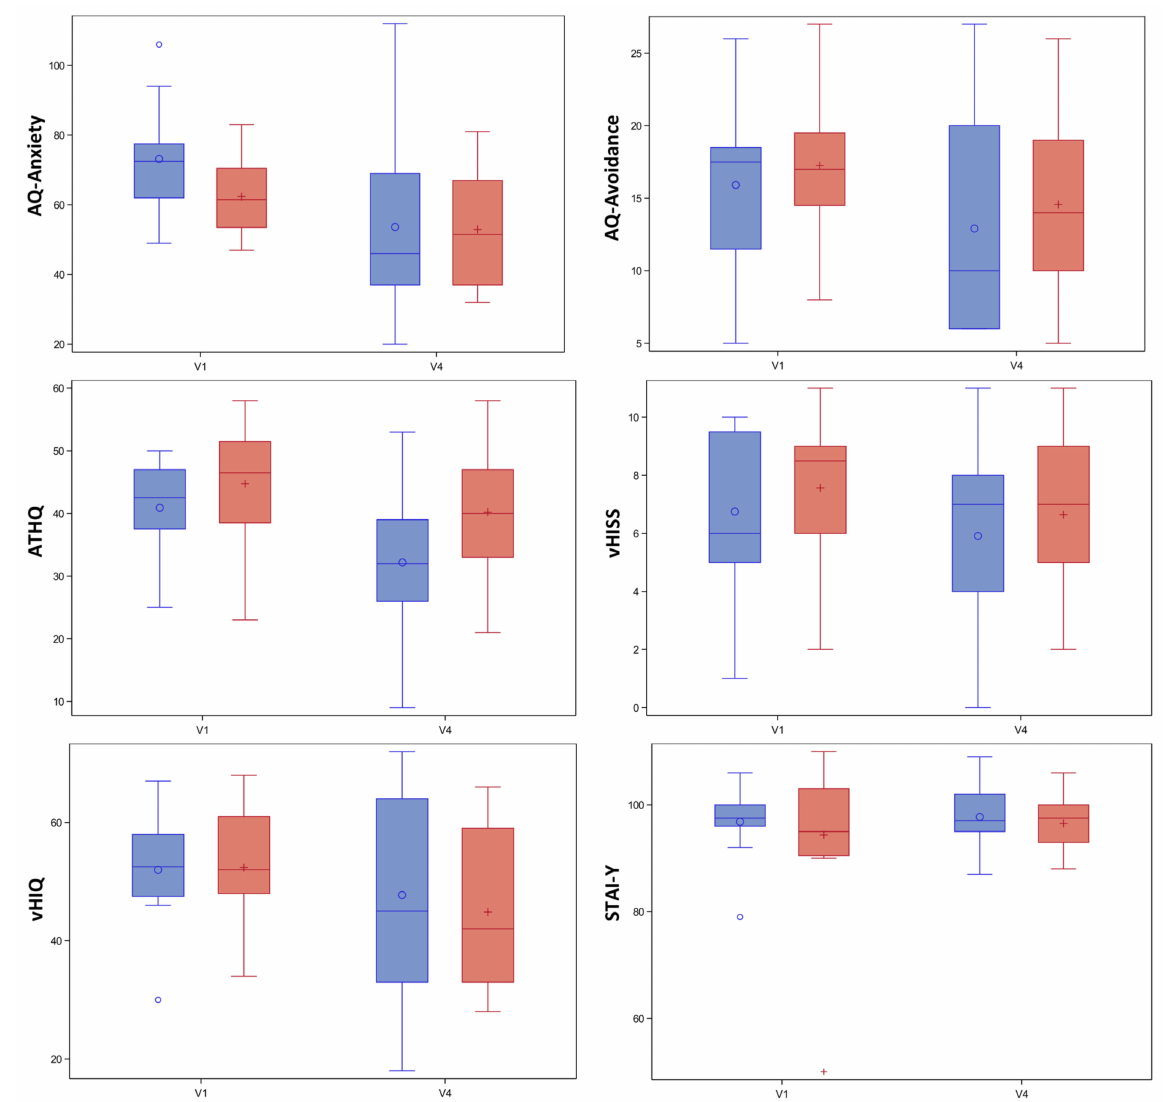
Figure 8. Boxplots of clinical scale scores between V1 and V4. In blue, the tDCS + VRET group ( n = 11) and in red, the sham + VRET group ( n = 14). Abbreviations: AQ: Acrophobia Questionnaire; ATHQ: Attitude Towards Heights Questionnaire; STAI: State-Trait Anxiety; vHISS: visual Height Intolerance Severity Scale; vHIQ: visual Height Intolerance Questionnaire; VRET: Virtual Reality Exposure